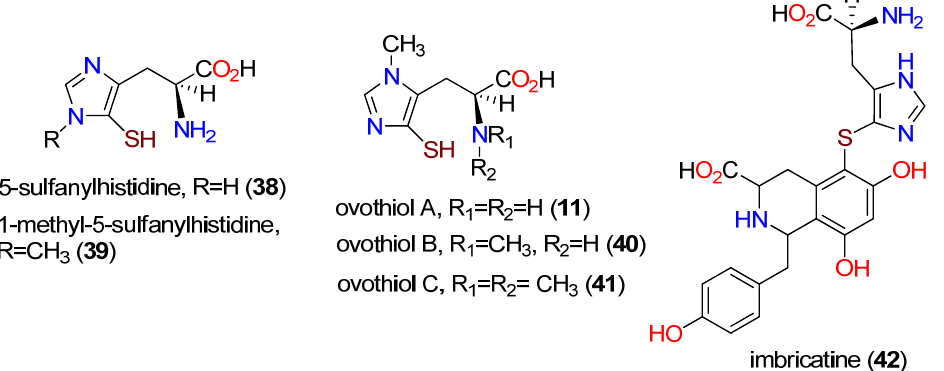
Figure 9. Structures of 5-sulfanylhistidine ( 38 ), 1-methyl-5-sulfanylhistidine ( 39 ), ovothiol A ( 11 ), ovothiol B ( 40 ), ovothiol C ( 41 ), and imbricatine ( 42